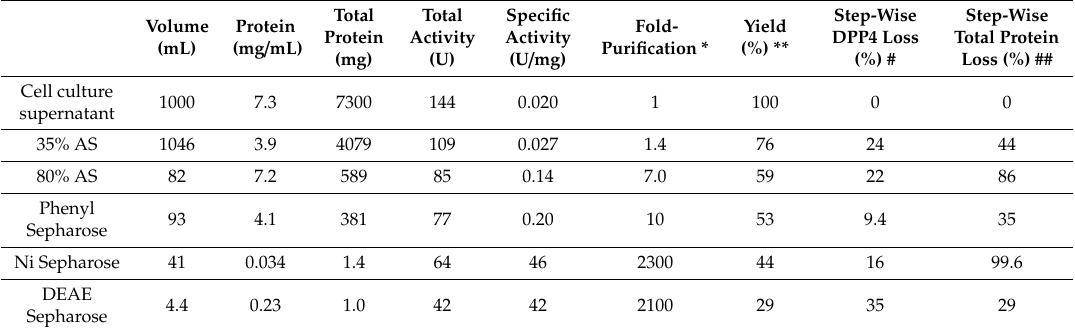
Table 1. Representative purification of DPP4 from Sf9